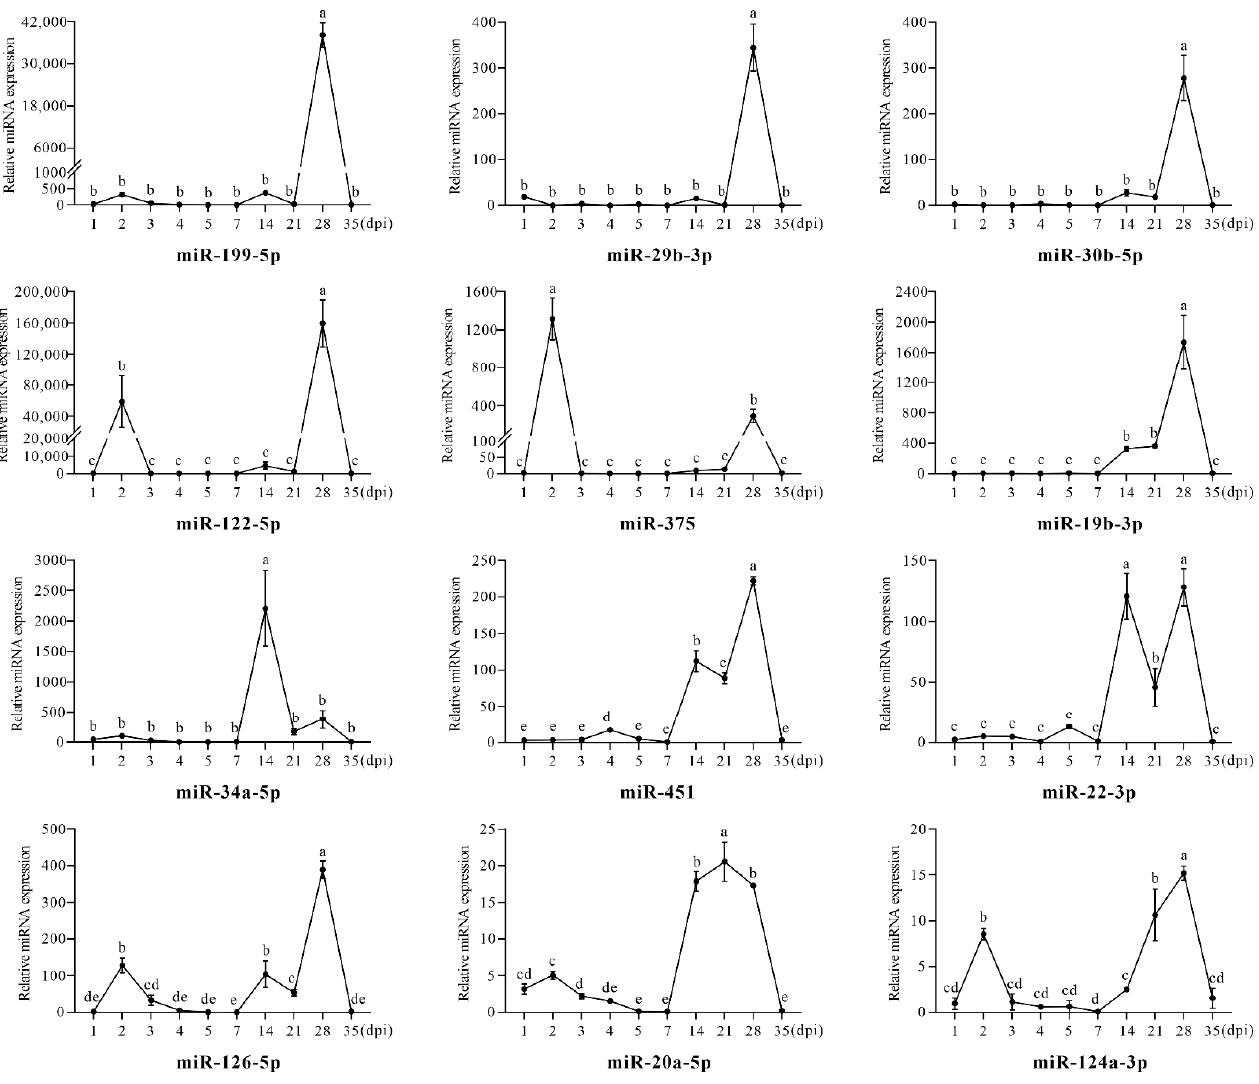
Figure 2. The relative expression levels of serum circulating miRNAs in Dex group. The different letters represent significant differences ( p < 0.05). letters represent significant differences ( p <